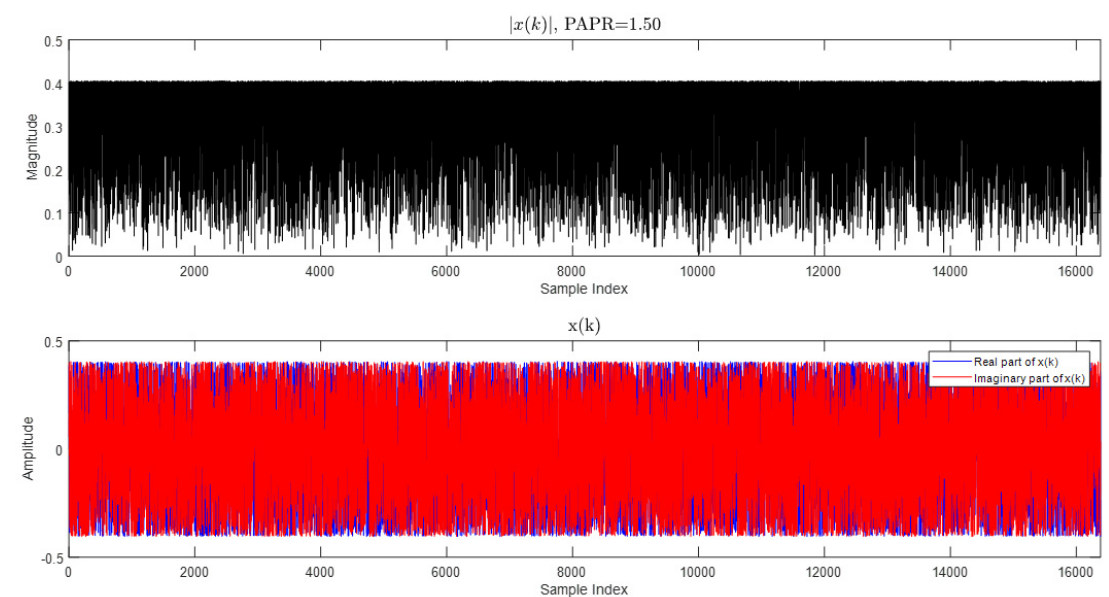
Figure 10. The PAPR optimized COSPAR signal (PAPR = 1.5). The power spectrum and ACF of the signal omitted here are the same as in Figure 7b,c.